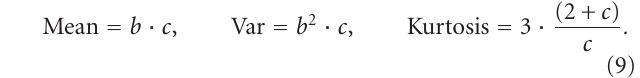
Figure 2: All above network probabilities in one place. These curves are plotted versus transmission probability ( τ i ) for a network of five stations.